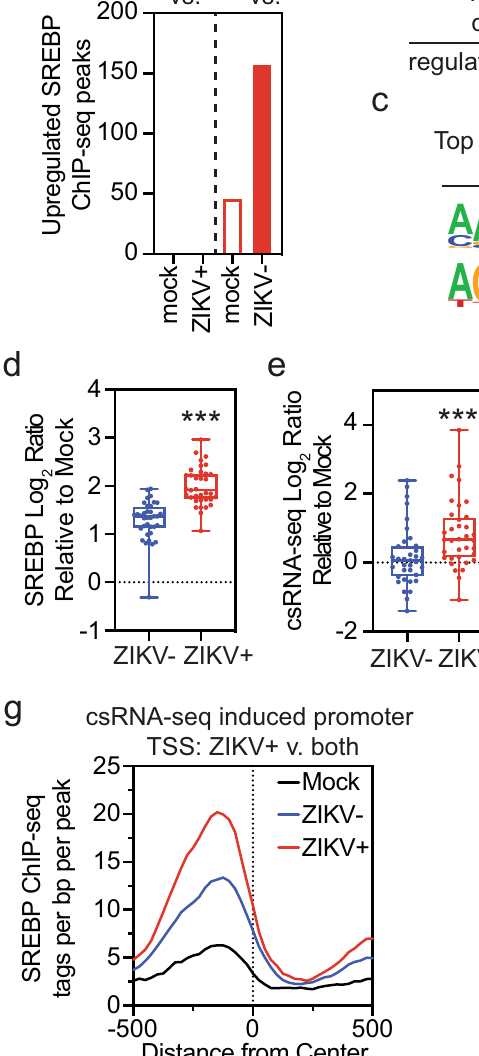
representing upregulated ZIKV+ SREBP peaks are shown. Box plots show the median value and extend from the 25th to 75th percentile, while the whiskers extend from min to max values. N =3 biologically independent experiments. *** P <0.001 by two-sided paired t test. f UCSC browser visualization of the FASN locus with RNA-seq, SREBP ChIP-seq, and csRNA-seq in Mock, ZIKV − , and ZIKV+ moDCs. Location of SREBP (SRE) motifs is indicated. g SREBP-binding relative to csRNA-seq promoter proximal TSS upregulated in ZIKV+ vs ZIKV − and Mock moDCs. Source data and exact P values are provided as a Source Data fi